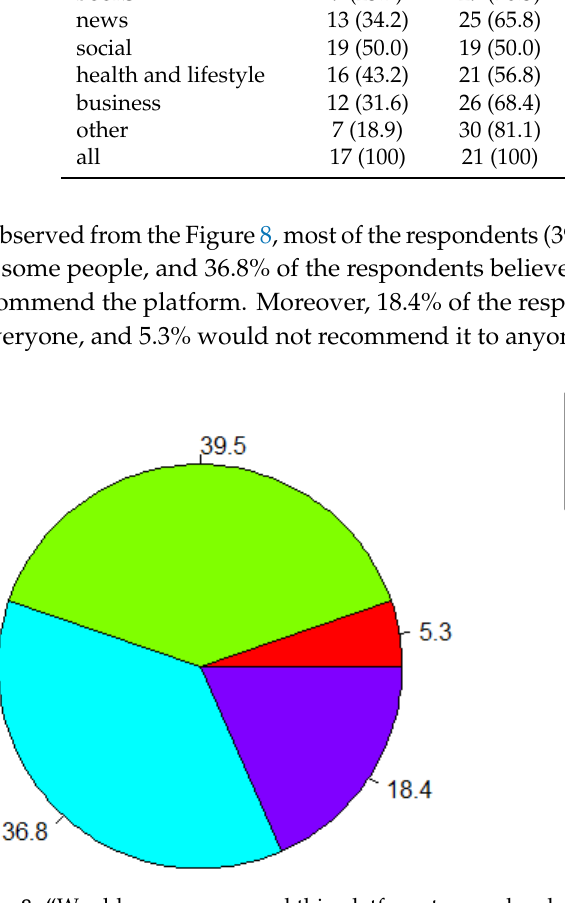
Figure 8. “Would you recommend this platform to people who might benefit from it?”